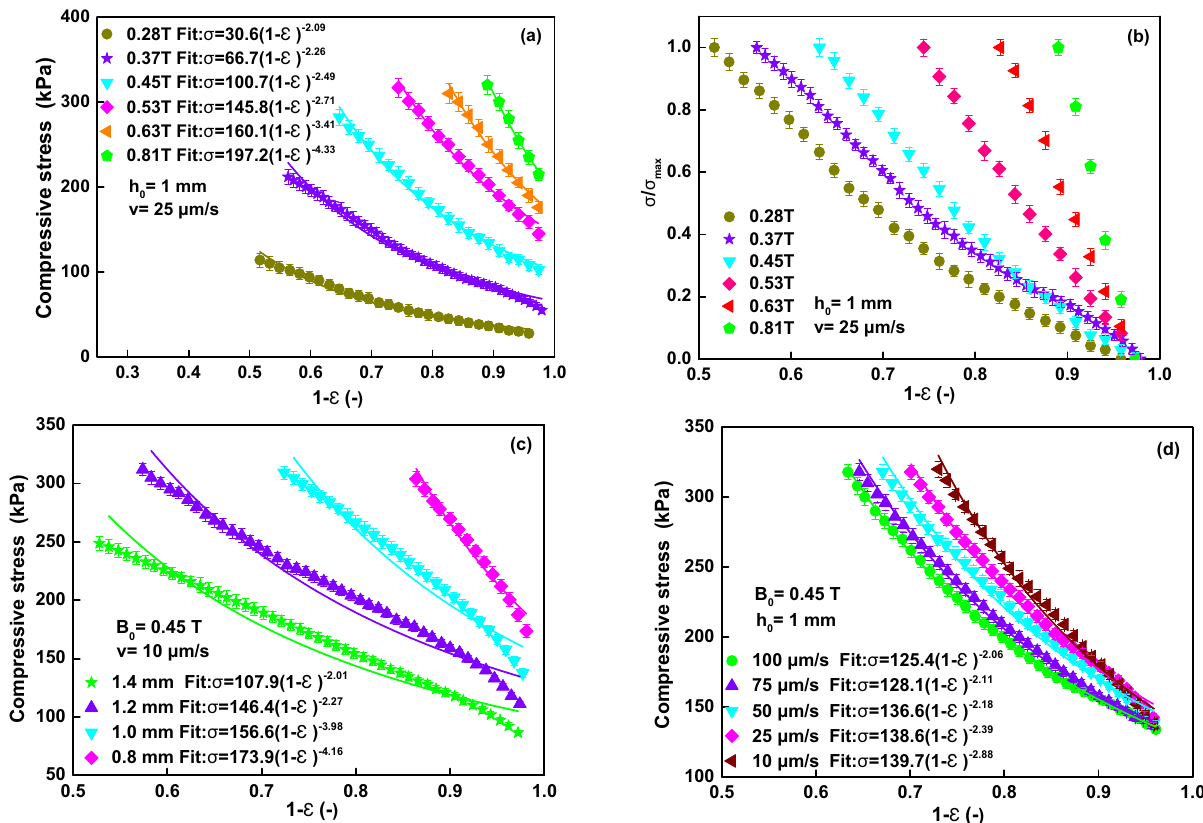
Figure 5. Compressive stress versus (1 − ε ). Symbols: experimental data. Lines: fitting curve. ( a ) at h 0 =1.0 mm v = 25 μm/s under different magnetic fields. ( b ) normalized compressive stress versus (1 − ε ) under different magnetic fields. ( c ) at B 0 = 0.45 T v = 10 μm/s under different original gap distances. ( d ) at B 0 = 0.45 T and h 0 =1.0 mm under different compressive